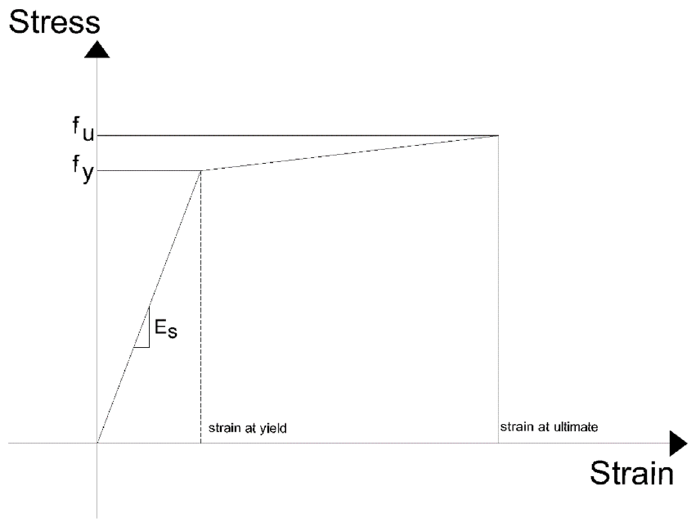
Figure 8. Constitutive law for the external tendon (Adapted from Refs. [19,20]).